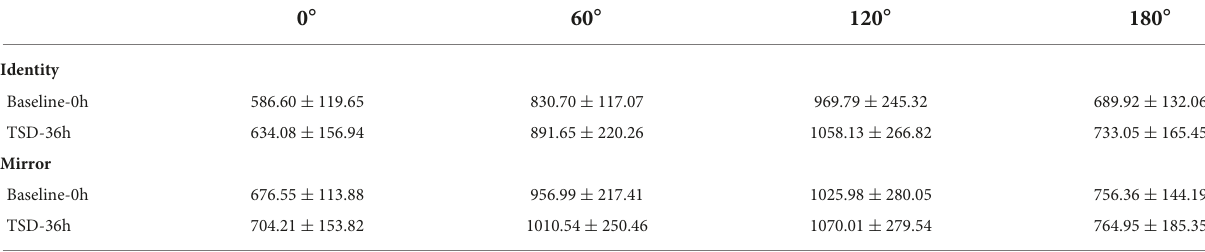
TABLE 2 Mean and standard deviation (SD) for the response time at baseline and TSD, separate for identical and mirror conditions.